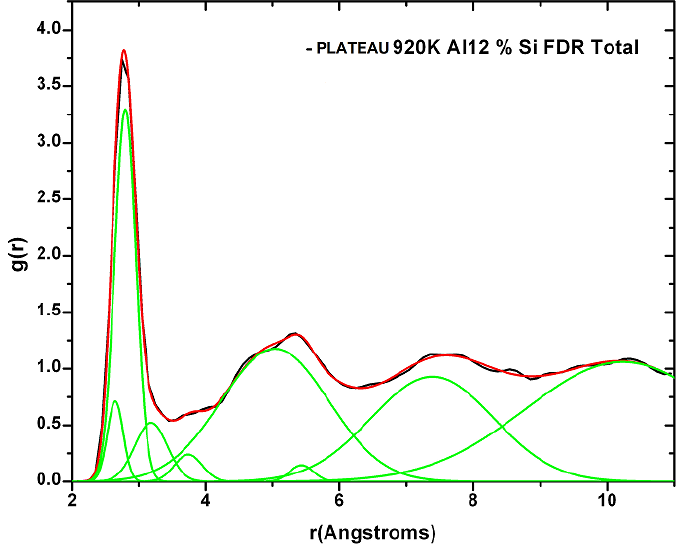
Figure 29. Deconvolution of the total RDF (black curve) for the la -Al12at%Si eutectic alloy. We obtain the smallest number of Gaussians (green curves) whose sum (red curve) reproduces the corresponding RDF. For the first neighbors we sum the areas that contribute to the first peak of the pertinent